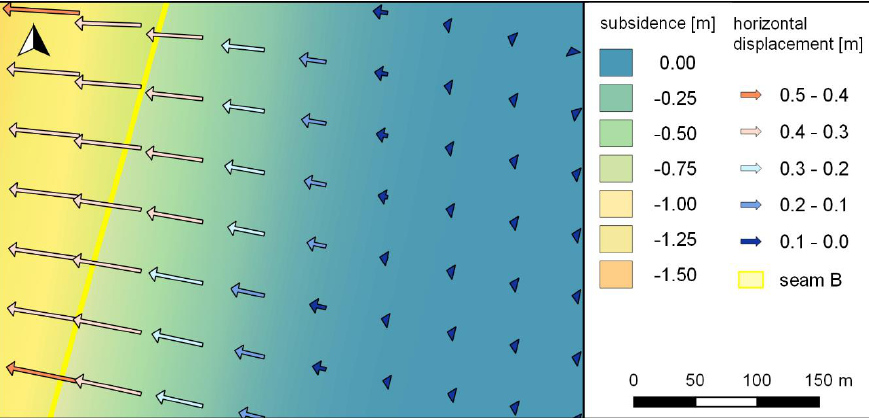
Figure 13. Forecasted subsidence and horizontal displacement at the Jaworzno site.